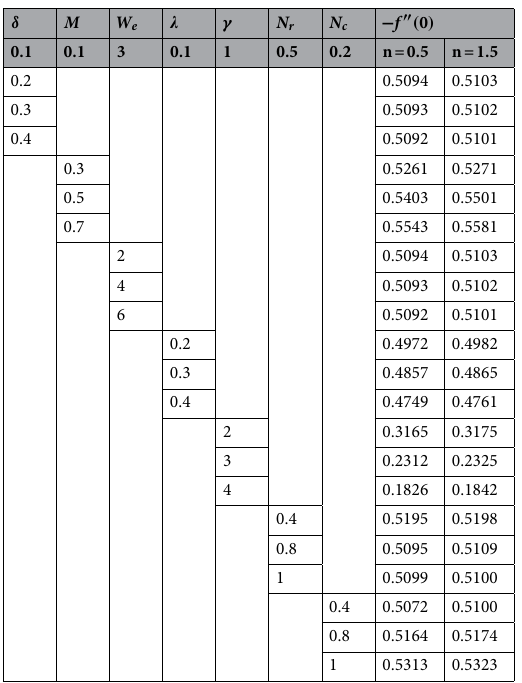
f ′′ ( 0 ) for the values of δ. −